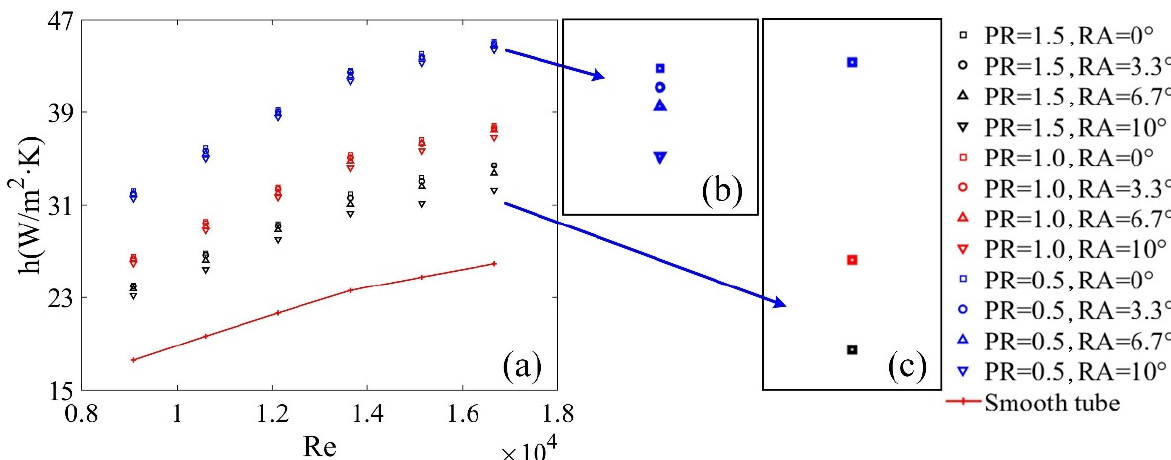
Figure 7. Effects of vortex generators on the h for different PR s and RA s. ( a ) the relationship of Re and h for these tubes with different PR s, RA s and Re s; ( b ) the relationship of RA and h when the values of PR and Re are the same; ( c ) the relationship of PR and h when the values of RA and Re are the same.